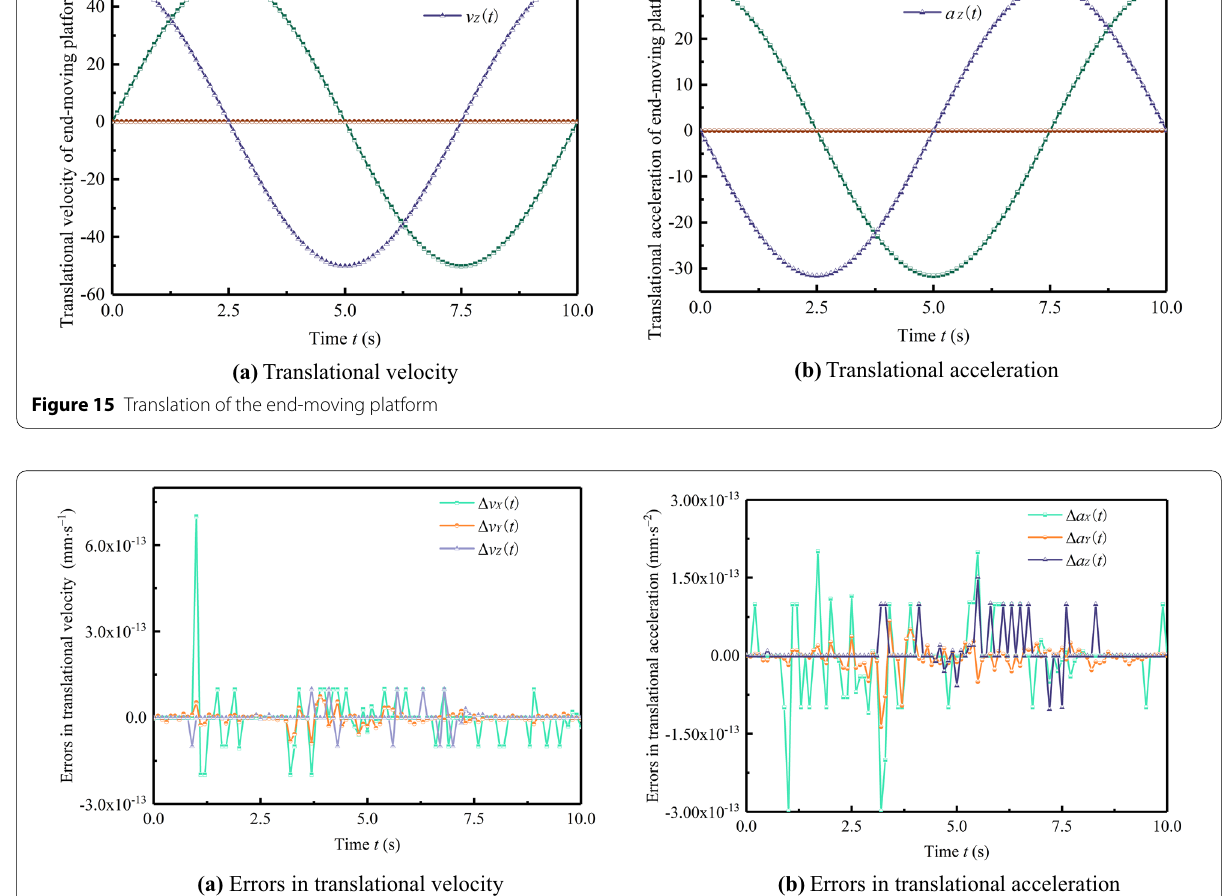
Figure 16 Translational motion error between the forward kinematics and target trajectory